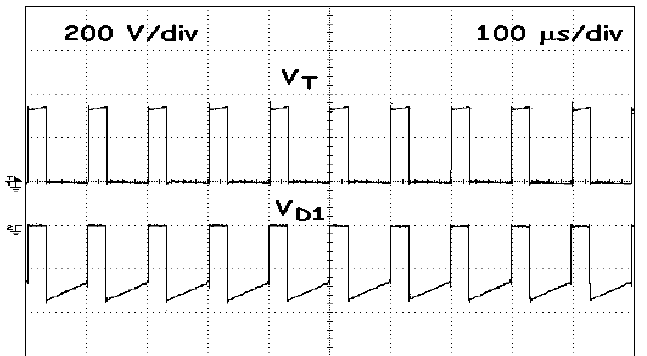
Figure 21. Experimental results for the voltage across the power switch S W in boost mode.